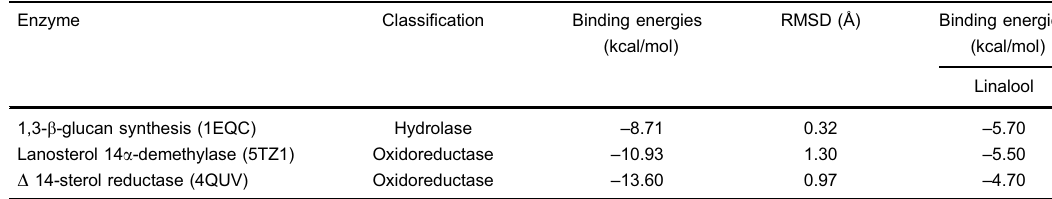
Table 4. Binding energies of Protein Data Bank (PDB) enzymes and tested compound.